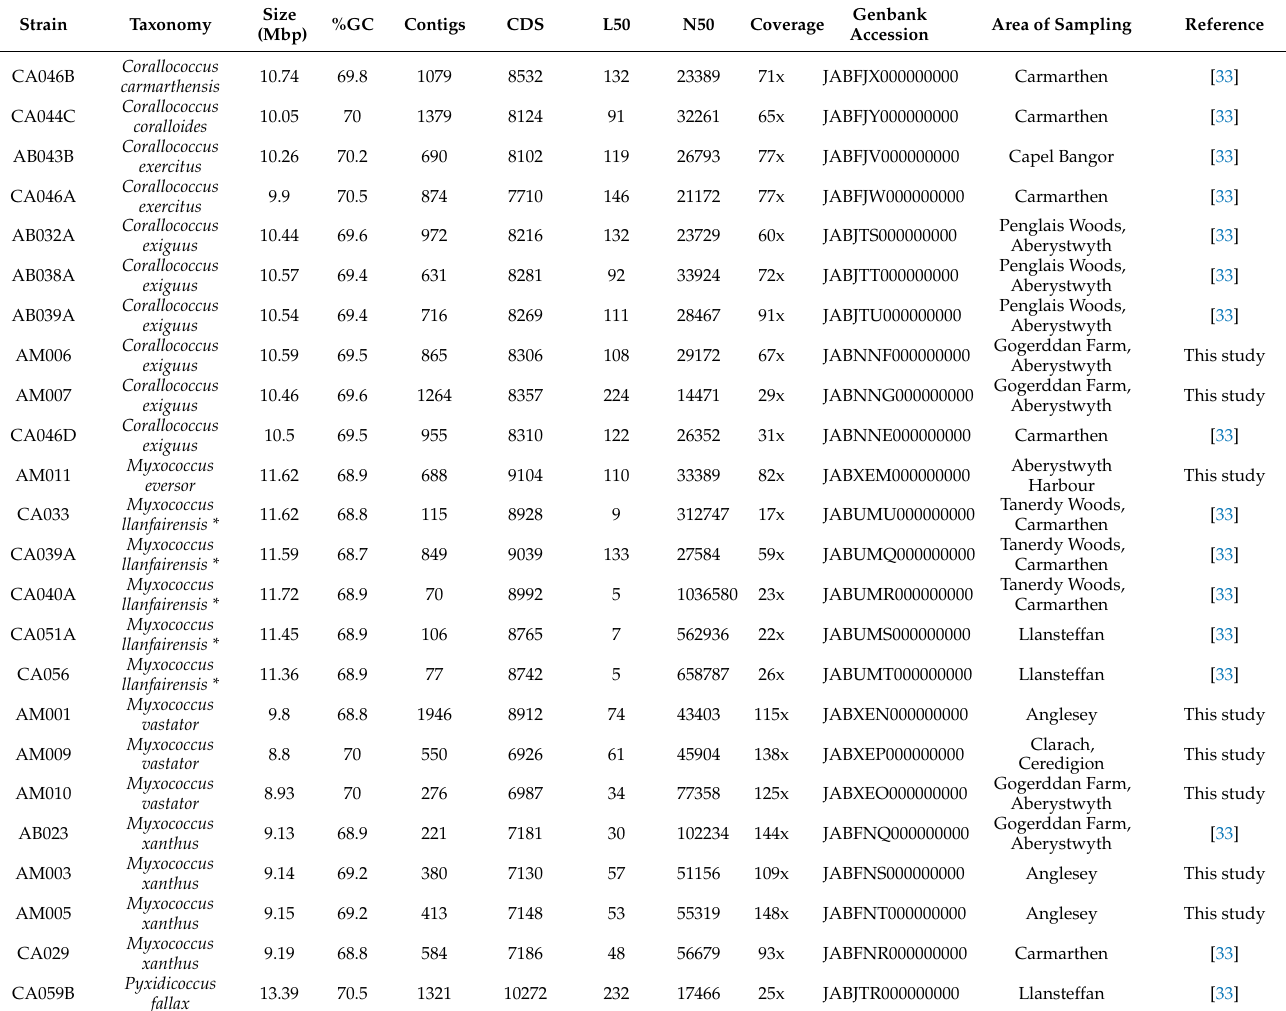
Table 2. Summary statistics of 24 genome sequences described here for the first time. The strains are environmental isolates and were assigned to species using genome-based taxonomic principles as described in the text (ANI and dDDH comparisons). Some of the strains (but not their genomes) have been described previously